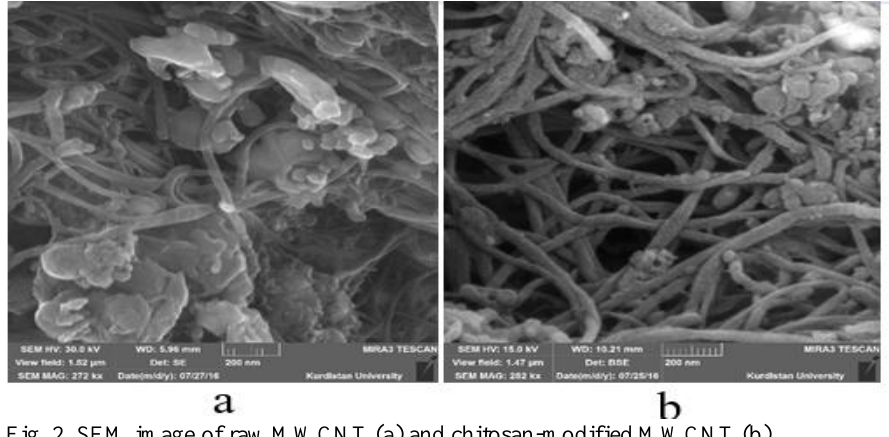
Fig. 2. SEM image of raw MWCNT (a) and chitosan-modified MWCNT